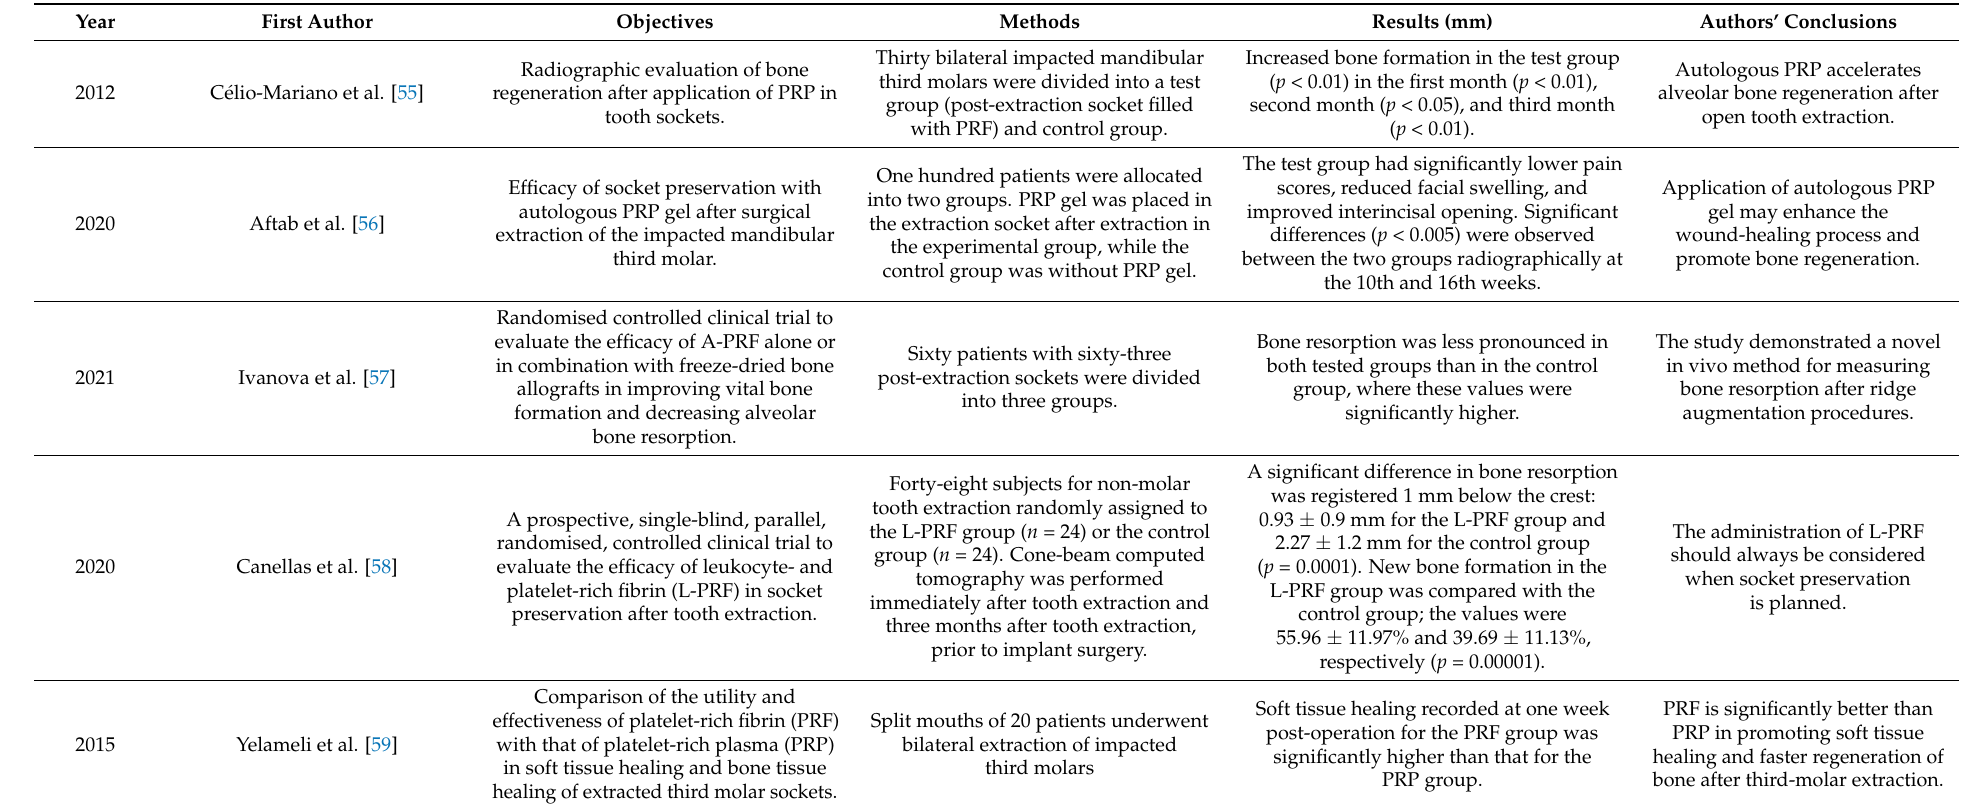
Table 3. Comparison between the 3 APC techniques (PRP, PRF, and CGF) in socket